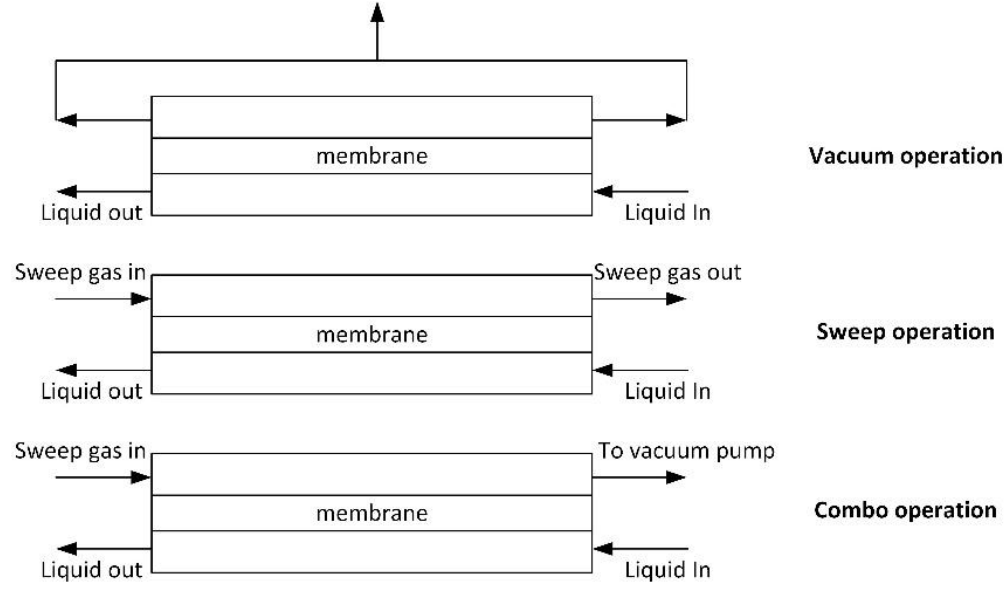
Figure 7. Different methods for dissolved oxygen removal from water (adapted from [82]).